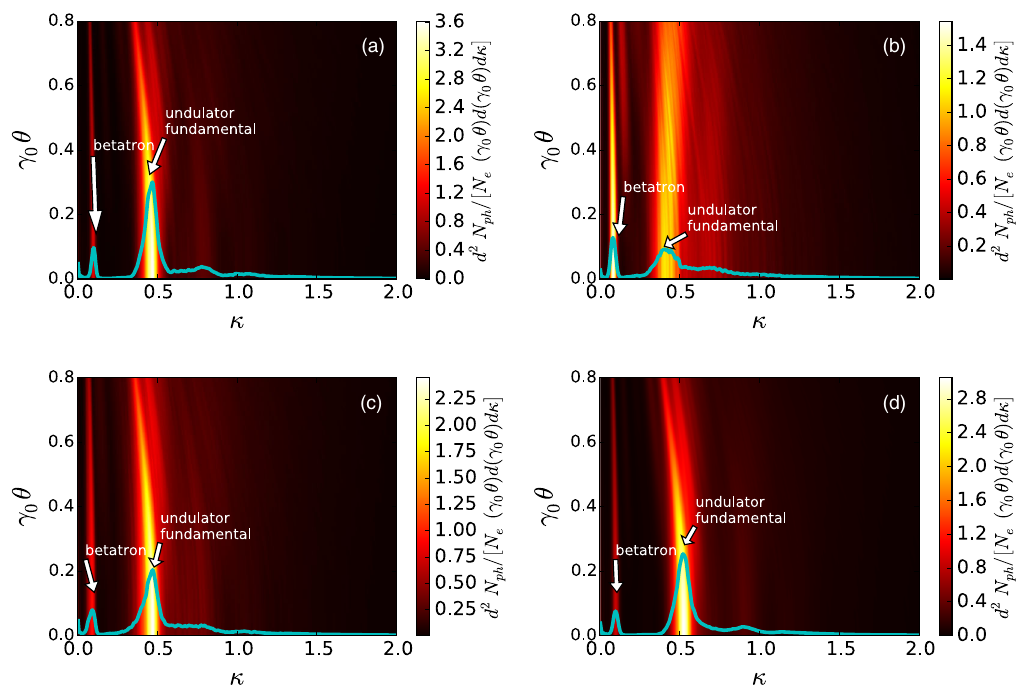
FIG. 5. Photon energy-angular spectrum as a function of both normalized photon energy κ (horizontal axis) and normalized angle γ 0 θ (vertical axis) for four cases: (a) electron beam is matched and optimally injected into the plasma undulator [with the exponential term in Eq. (18) neglected]; (b) electron beam is matched, but injected on-axis into the same undulator; (c) electron beam is injected optimally, but unmatched to the same undulator; (d) electron beam is injected optimally and matched to the undulator, with exponential term in Eq. (18) included. Undulator parameters and beam parameters are the same as Figs. 3(a) – 3(d), with N u ¼ 30